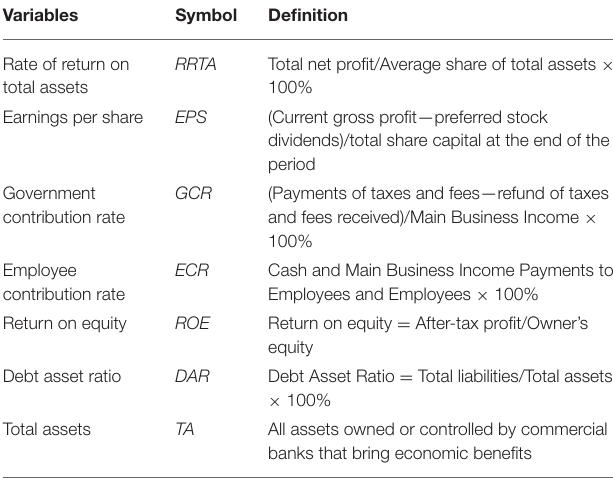
TABLE 1 | Definitions of